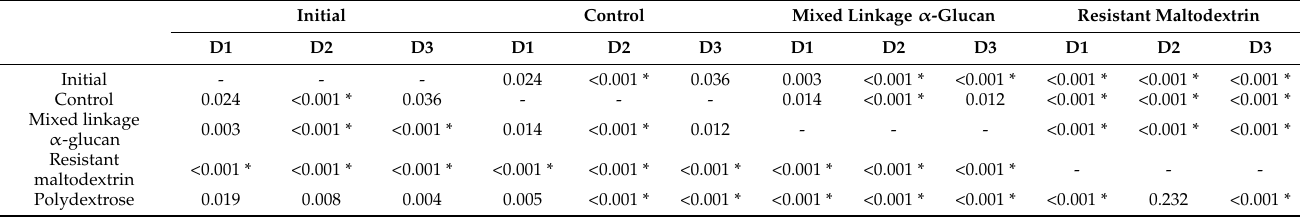
Table 1. Analysis of Molecular Variance (AMOVA) showing separation of glucan categories for each donor (D1, D2, D3), calculated by mothur with a default alpha of 0.05 and Bonferroni correction for multiple comparisons. * Indicates statistically significant differences between the glucan categories.